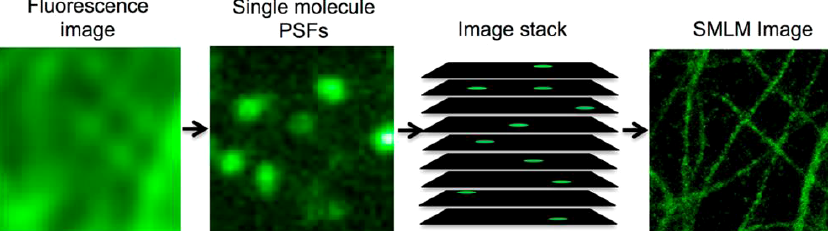
Fig. 1. Imaging principle of SMLM. The di®raction-limited epi-°uorescence image where all °uorophores emit photons (panel 1). For SMLM, a majority of °uorophores are switched to a dark state, allowing subsets of °uorophores to be imaged without spatial overlap and to be localized at high precision (panel 2). The activation and imaging processes are iterated to accumulate thousands of frames of single-molecule emissions (panel 3) and a super-resolution image is reconstructed from numerous localized emissions (panel 4). Adapted with permission from Ref.